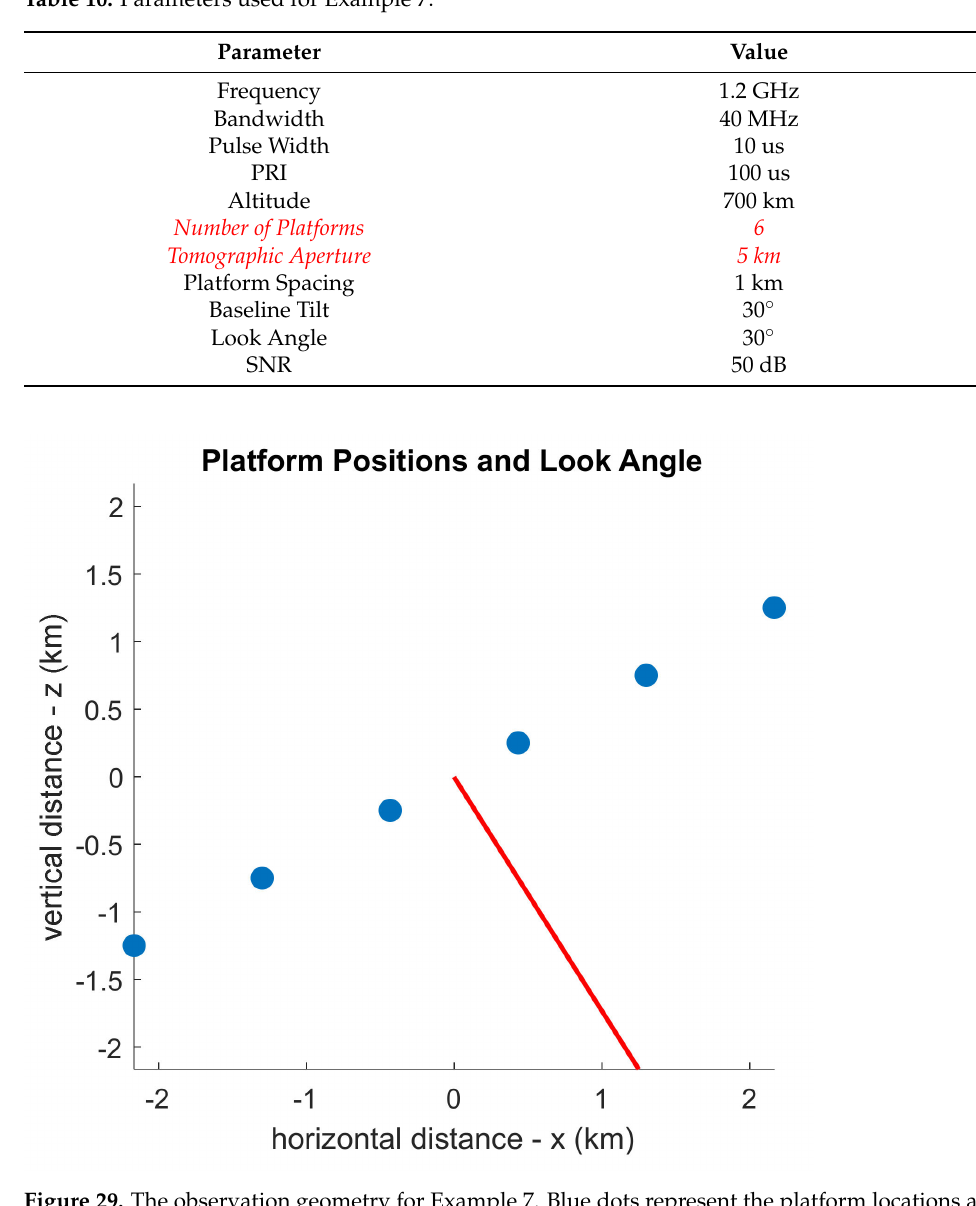
Figure 29. The observation geometry for Example 7. Blue dots represent the platform locations and the red line represents the look